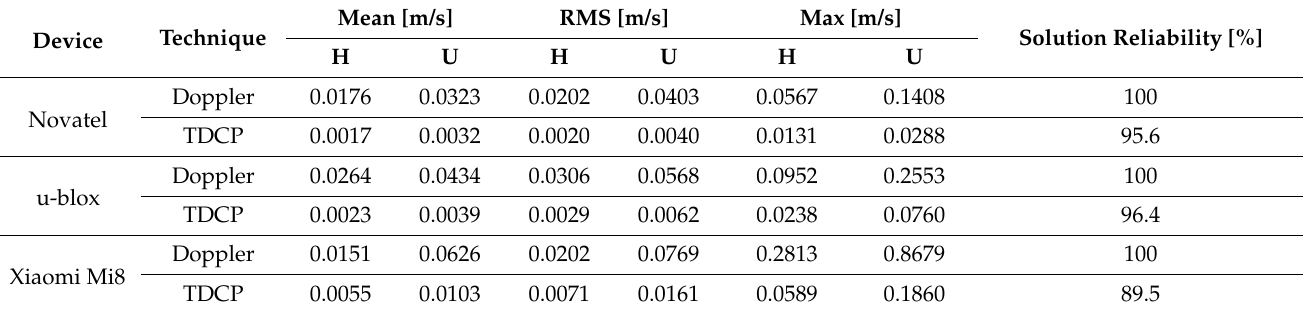
Table 2. Error analysis considering TDCP and Doppler techniques for Novatel Geodetic